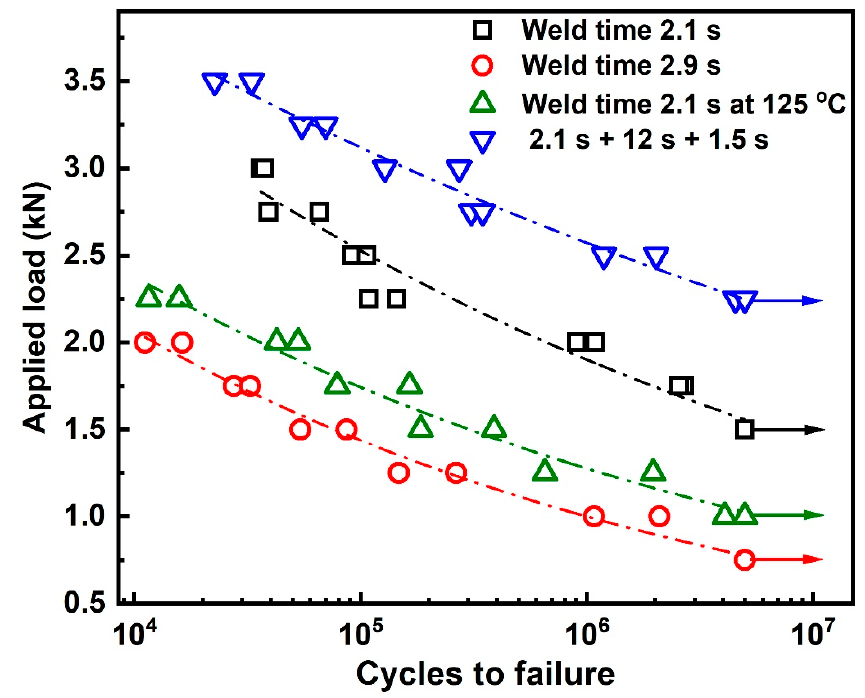
Figure 9. Fatigue life data for joints with various welding parameters.